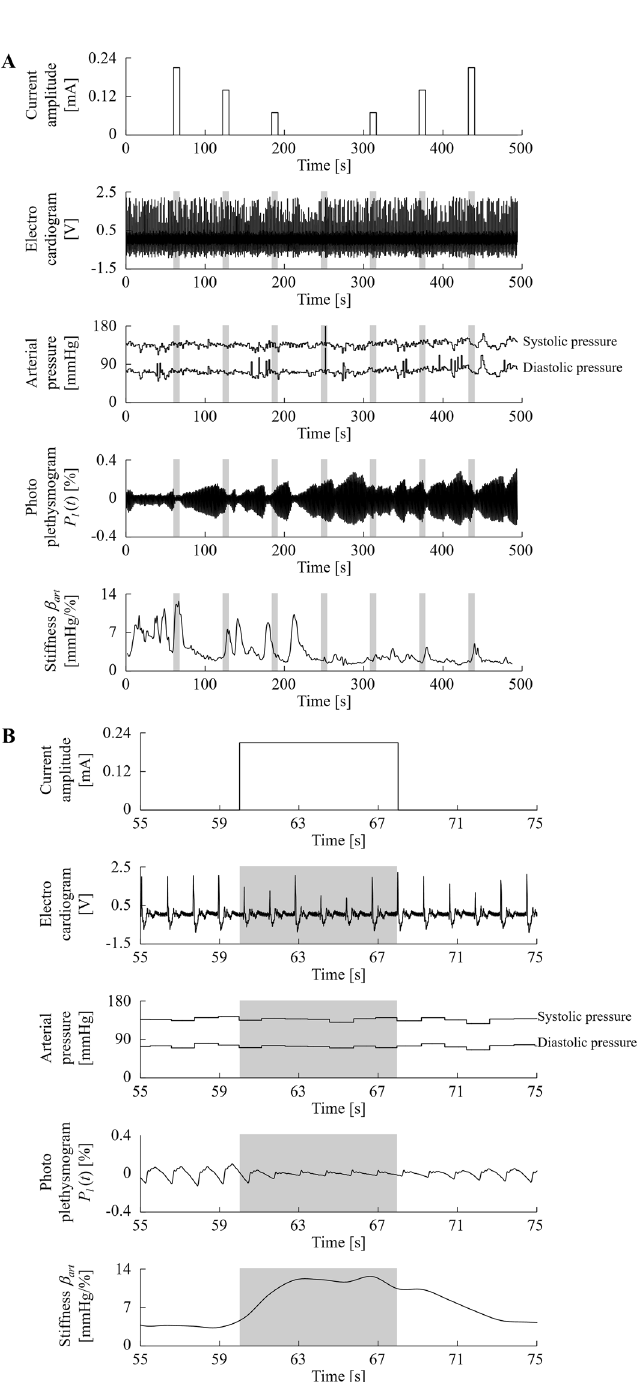
Figure 6. Electrocardiograms, systolic and diastolic blood pressure, photo-plethysmography, and estimated stiffness ( β art ) of Participant A in session 3. ( A ) The entire duration of session 3; ( B ) 55 s to 75 s, corresponding to the first electrocutaneous stimulation task with the strongest electrocutaneous stimulus (1.5 ×